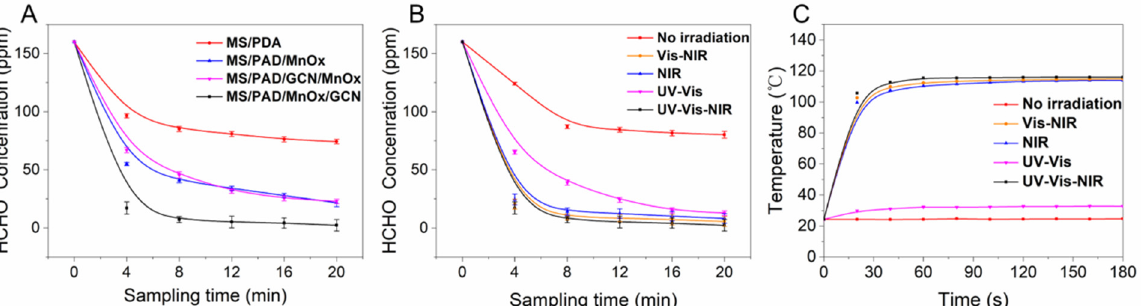
Figure 2. ( A ) Catalytic performance for HCHO degradation under the UV-Vis-NIR irradiation; ( B ) catalytic performance of catalyst MS/PDA/MnOx/GCN for HCHO degradation under irradiation with different wavelength ranges; ( C ) temperature change for catalyst MS/PDA/MnOx/GCN under irradiation with different wavelength ranges.